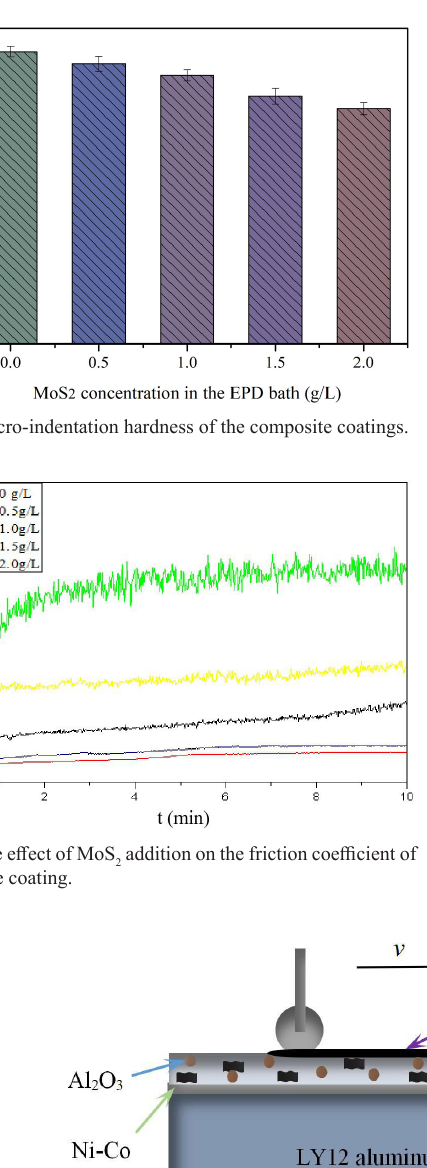
Figure 9. Schematic diagram of friction process of Ni-Co-Al